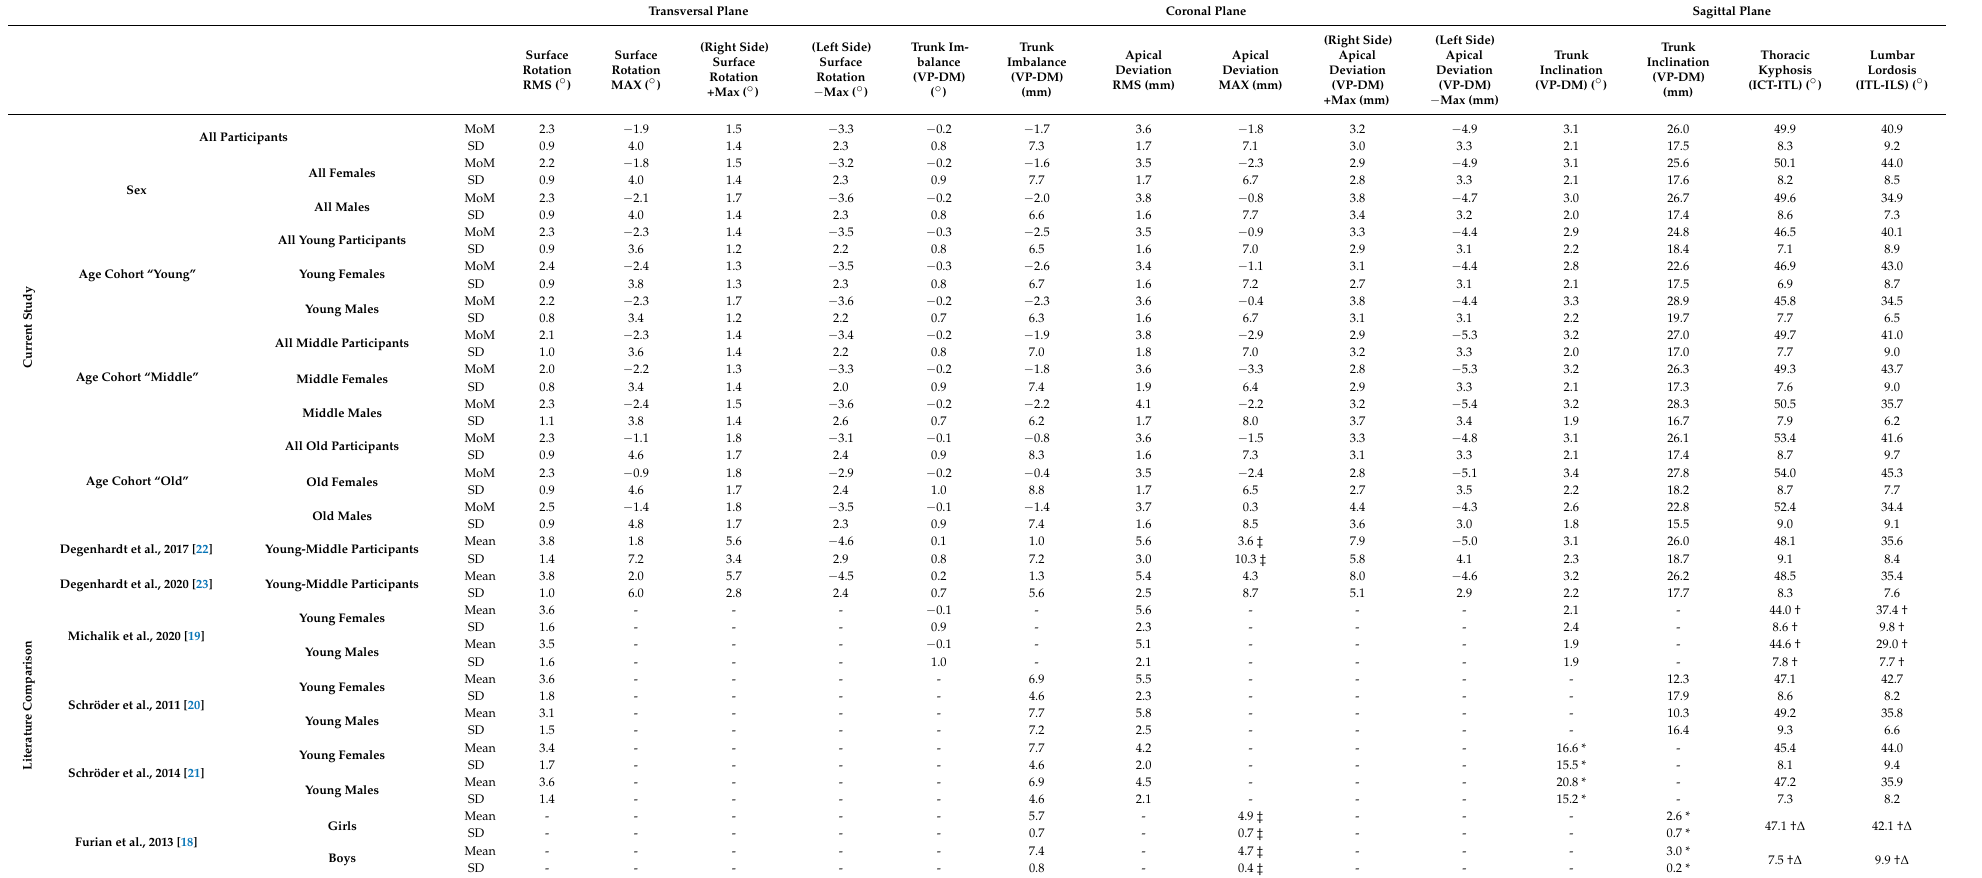
Table 6. Comparison of the results for the global spine parameters from the current study with those of previous